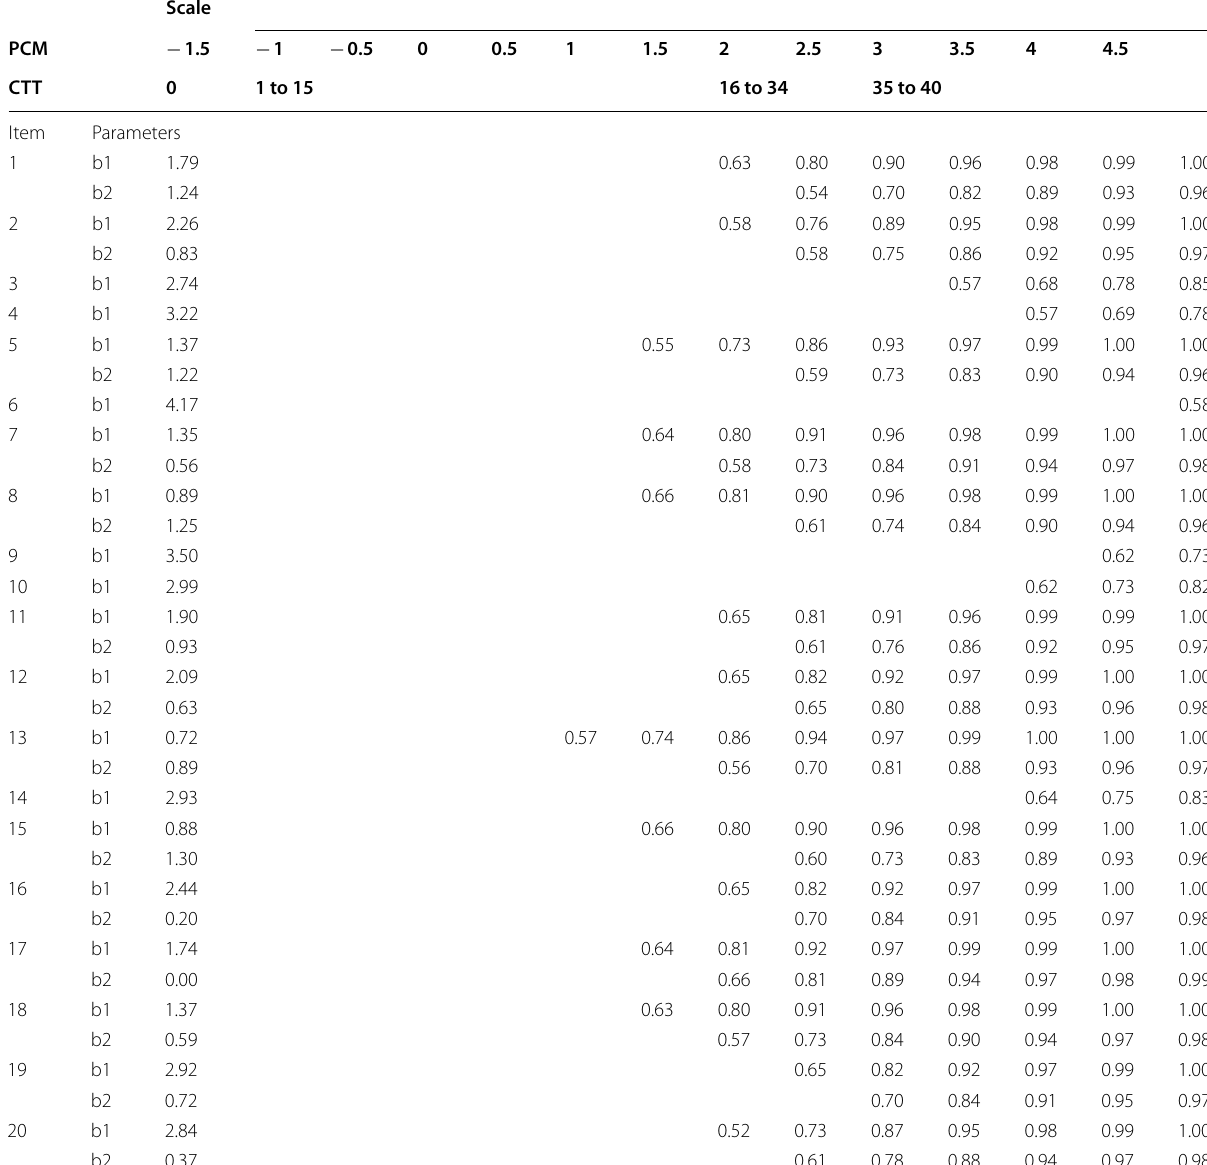
Table 5 Scale and positioning of the PFDI-20 items according to the PCM and